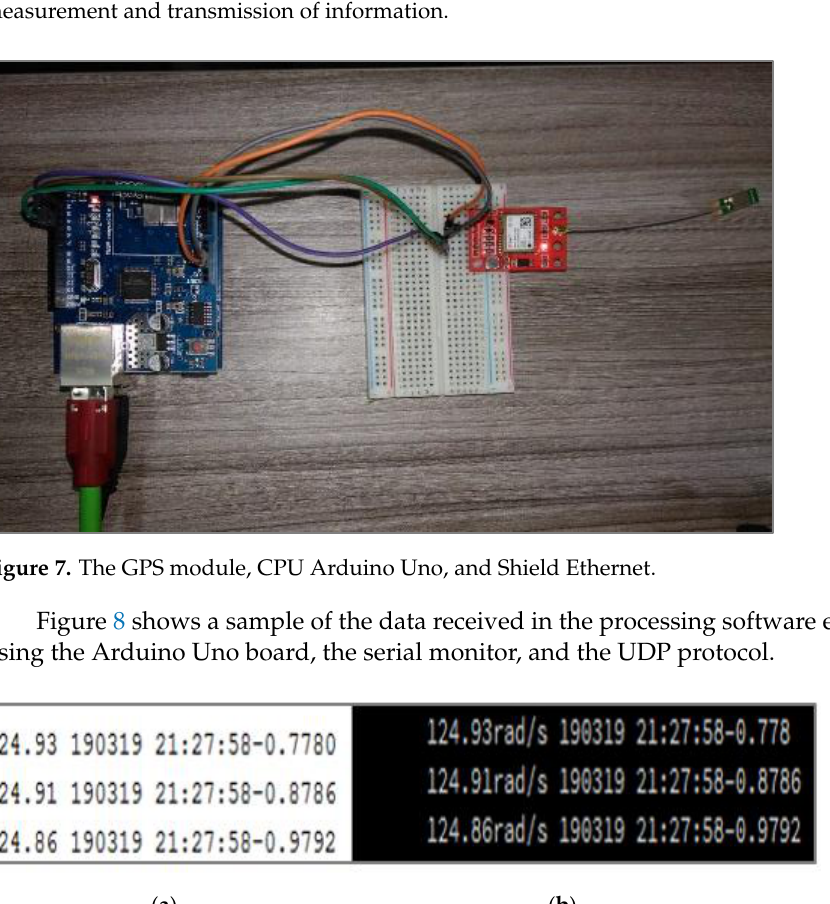
Figure 6. ( a ) A synchronous generator of 5 KVA at 1200 RPM and ( b ) the experiment for the meas- urement and transmission of information.